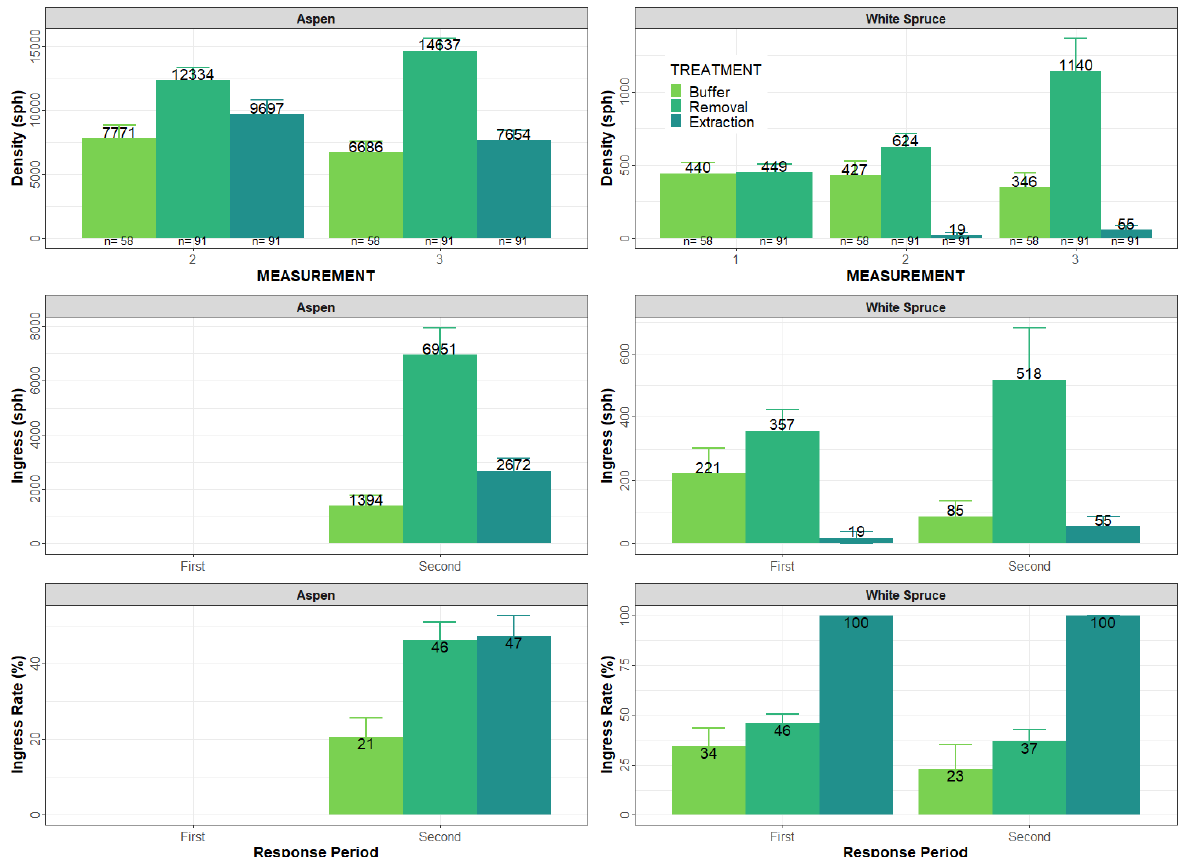
Figure 5. Sapling density and ingress by species and by treatment. Lower tagging limit is 1.3 m height and upper tagging limit is 7.1 cm DBH for both species. Means and standard errors (error bars) are presented. n is sample size (number of plots). Note: First response period (between Measurement 1 and 2) ranged from 5 to 7 years; for the second response period (between Measurements 2 and 3), the time interval was 5 years; and between Measurements 1 and 3, the overall time interval was between 10 and 12 years. Subplots with no recorded desired trees were accounted in averaging (as zero density), but were not used in the computation of ingress rate. Due to a lack of data for Measurement 1, aspen density at Measurement 1 and ingress for the first response period could not be calculated.